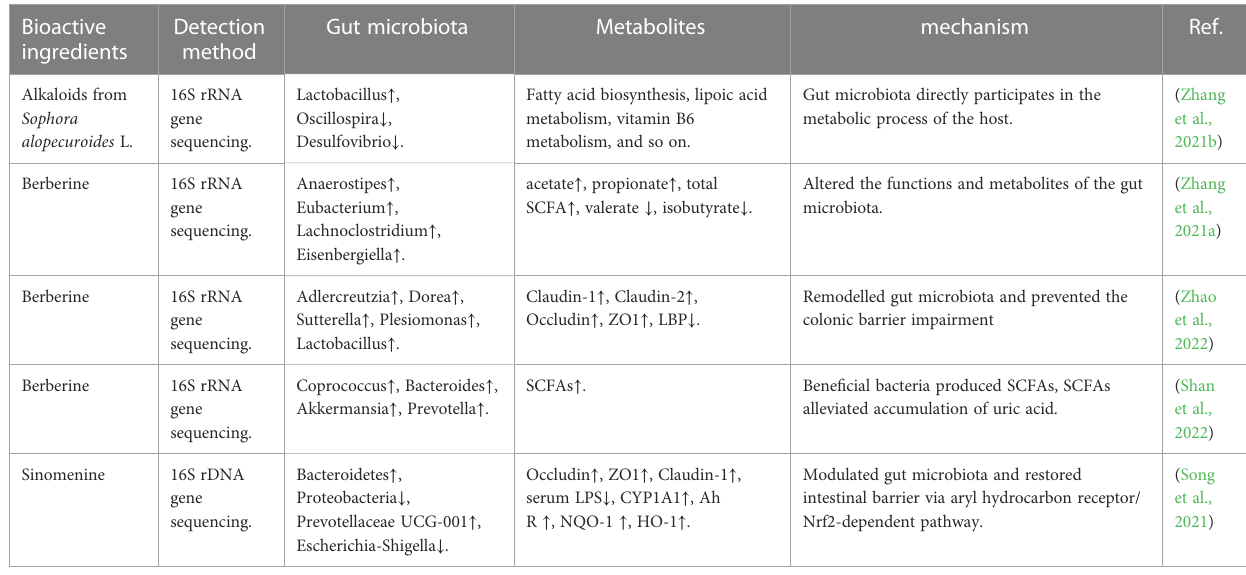
TABLE 4 The alkaloid from TCM regulated gut